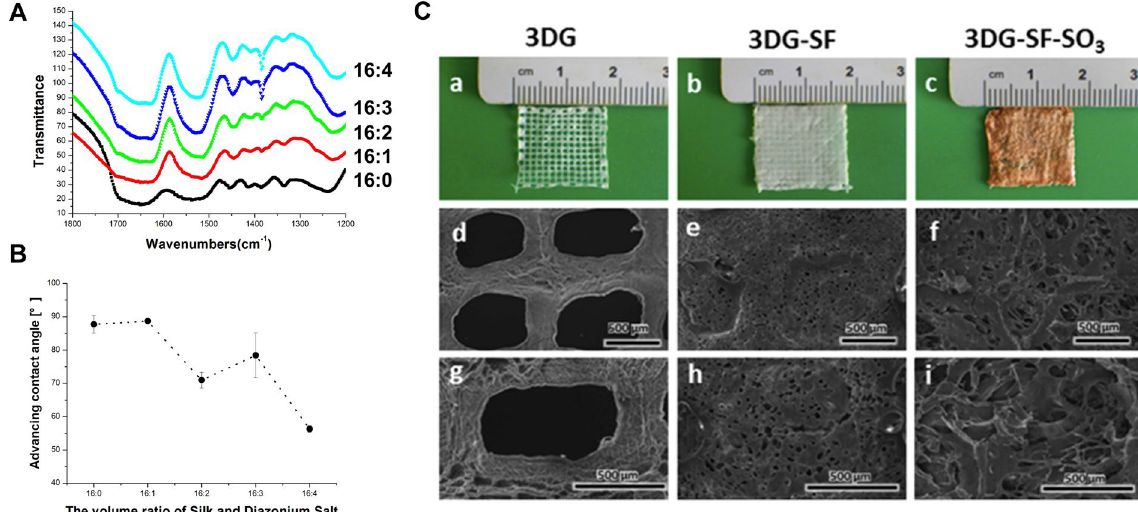
Figure 1. Characterization of scaffolds. ( A ) Comparison of the ATR-FTIR spectra of unmodified and sulfonated silk. ( B ) Advancing contact angles of native SF and SF derivatives with 0, 1, 2, 3 and 4 volumes per 16 volumes of silk. ( C ) Micrographs of 3D printed scaffolds (3DG) (a), SF coated 3D printed scaffold (3DG- SF) (b) and SF derivatives coated 3D printed scaffold (3DG-SF-SO 3 ) (c). Scanning electron microscopy (SEM) images of 3DG scaffold (d and g), 3DG-SF scaffold (e and h), and 3DG-SF-SO 3 scaffold (f and i), with (g,h,i) at high magnification. The thickness of each layer is 100 μ m, and the whole thickness of printed gelatin and gelatin